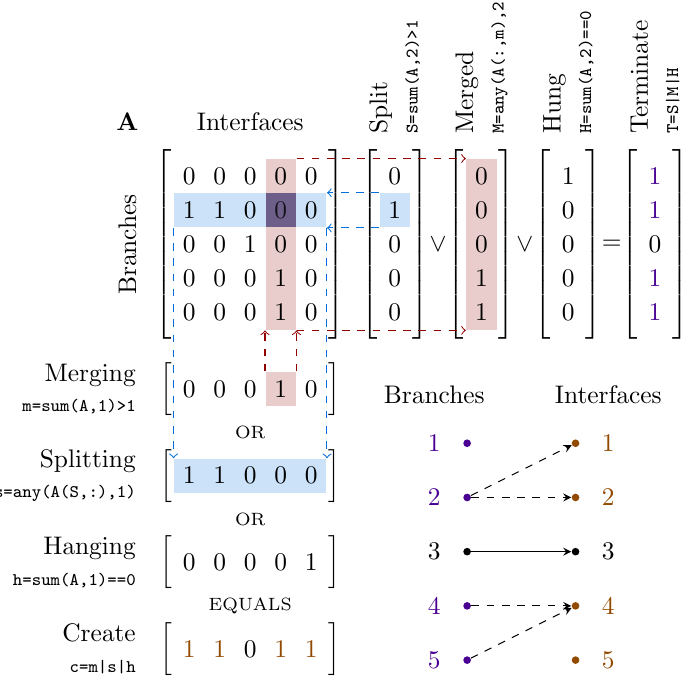
Figure 5. A (demonstrative) resolved adjacency matrix that is used to build an evolution matrix directly from individual displacement fronts, involving five active evolution branches at frame k and five displacement fronts to be collected in frame k + 1. Branch-related events are shown to the right of the matrix and front-related events are shown below the matrix, accompanied by their MATLAB expressions. The lower right diagram displays the recognized links between current fronts and existing non-terminated branches. The dashed arrows describe topology-changing events and the solid arrow represents a moving